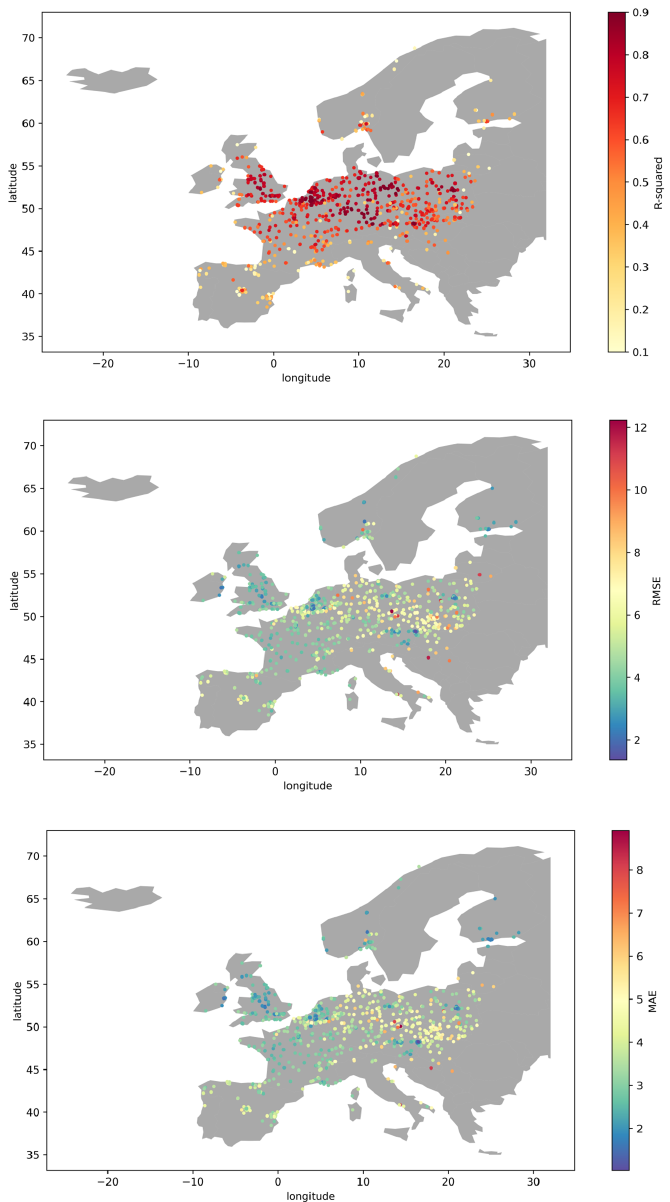
Figure 4. Spatial distribution of the site-based cross validation of coefficient of determination, the root mean square error, and the mean absolute error.